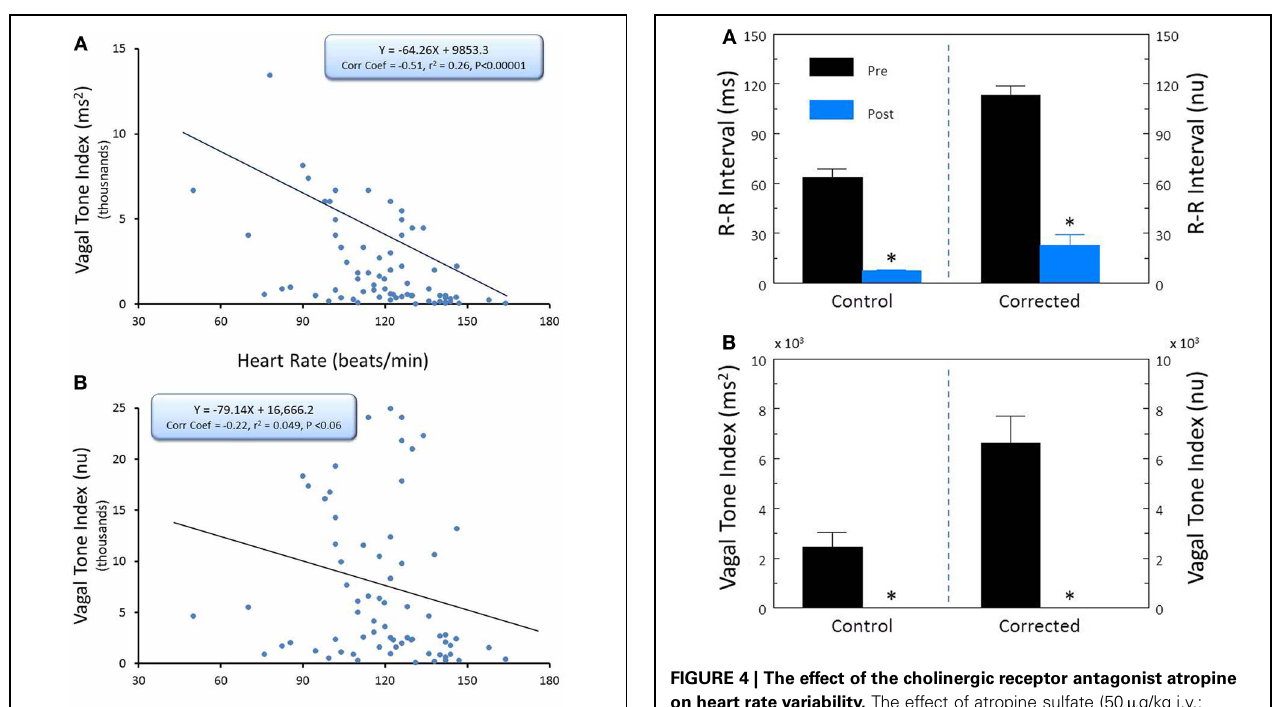
FIGURE 4 | The effect of the cholinergic receptor antagonist atropine on heart rate variability. The effect of atropine sulfate (50 μ g/kg i.v.; n = 25) on total heart rate variability (standard deviation of R-R interval, RRSD) without and with correction (RRSD/mean RRsec) are displayed in (A) . The effects of this drug on the high frequency variability (cardiac vagal tone index, 0.24–1.04 Hz) without and with correction [cardiac vagal tone/(mean RRsec) 2 ] are shown in (B) . Note that despite correction for large increases in heart rate, atropine still provoked large reductions in both RRSD and the cardiac vagal tone index. Thus, cardiac parasympathetic activity is responsible for a large portion of the heart rate variability independent of changes in HR. ∗ P < 0 . 01 pre (black bars) vs. post (blue bars); pre = last 30s before atropine administration, post = 30s interval recorded 5min after atropine treatment. nu, normalized units following HR